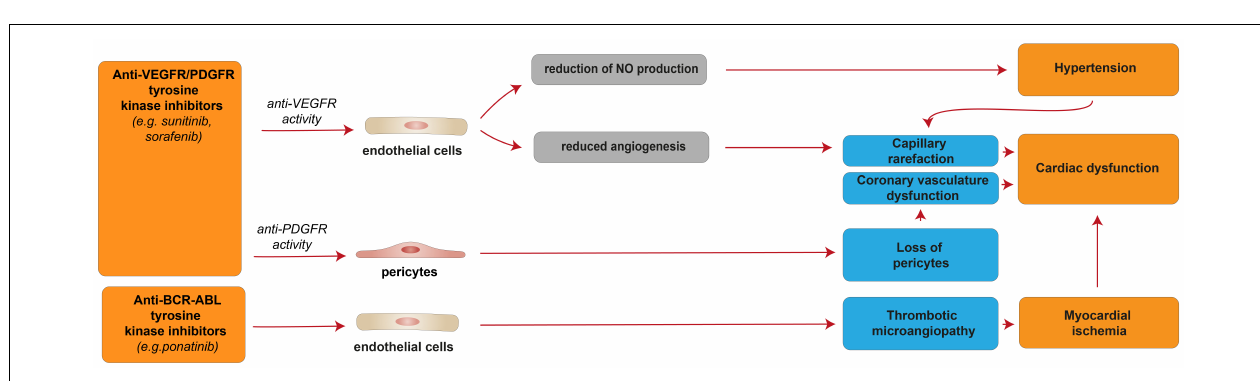
FIGURE 6 | Cellular and molecular mechanisms of the cardiotoxic effects exerted by VEGFR/PDGFR and BCR-ABL and tyrosine kinase inhibitors. Schematic diagram showing the impact of VEGFR/PDGFR and BCR-ABL inhibition, resulting in a reversible cardiac disfunction. Anti-VEFGR activity impairs cardiac function by inducing capillary rarefaction consequent to reduced angiogenesis or hypertension derived from reduced NO production. Anti-PDGFR activity induces cardiac dysfunction by promoting the loss of pericytes, which in turn impairs the coronary vasculature. Anti-BCR-ABL inhibition may results in myocardial ischemia and cardiac dysfunction consequent to thrombotic